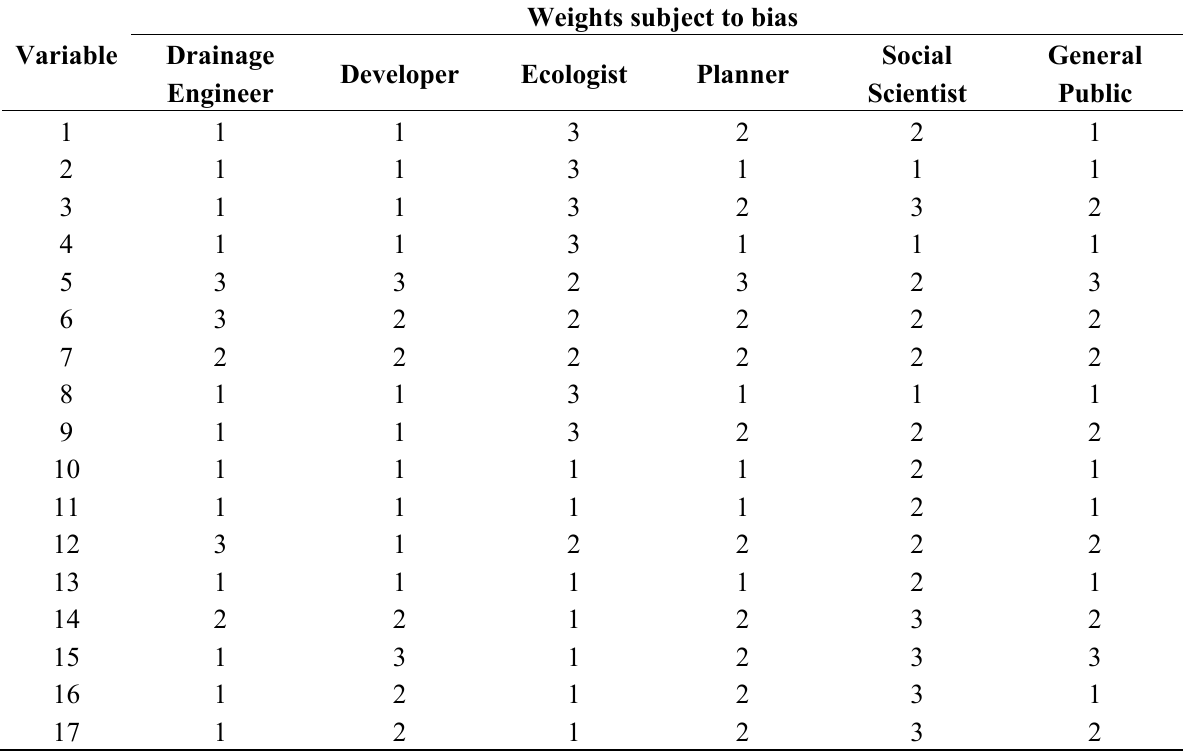
Table 3. Weights for ecosystem service variables (Table